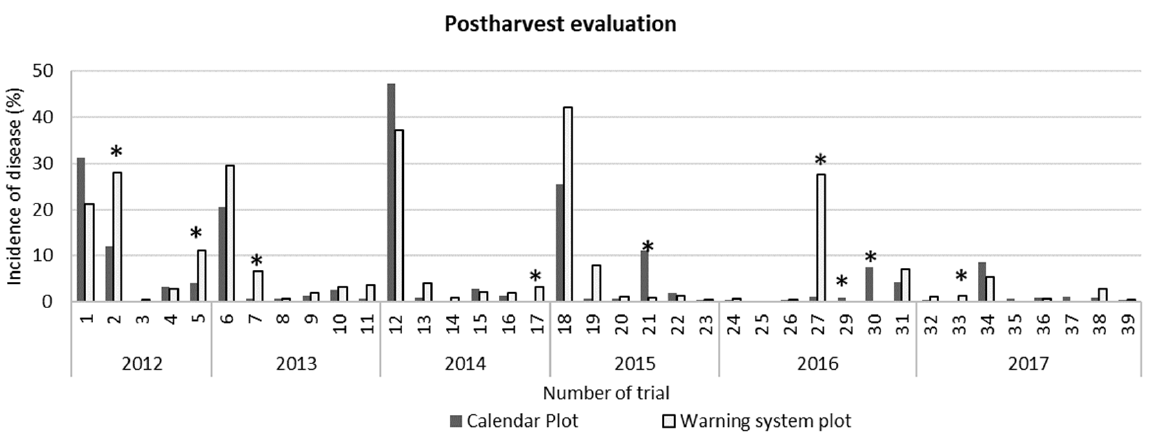
Figure 2. Correlation between the incidence of disease recorded in the field in the warning system and calendar plots plotted in Axis Y and X, respectively. Outliers were not included in the correla ‐ tion.